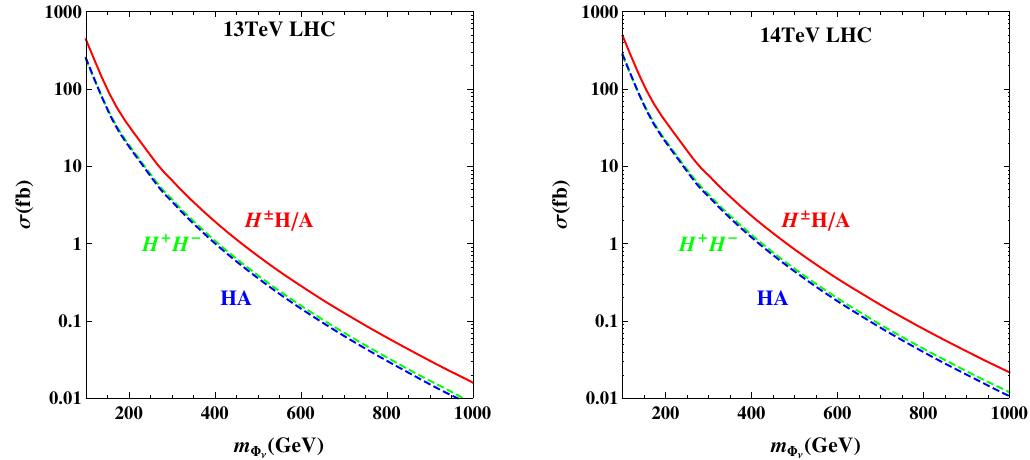
; m N ) = (300 ; 200) GeV. H + R